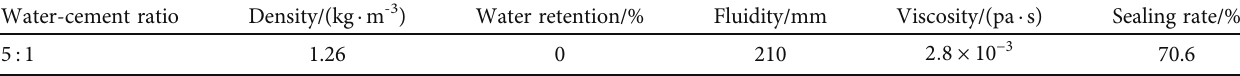
Table 1: Physical parameters of the inorganic slurry with the water-cement ratios of 5: 1.